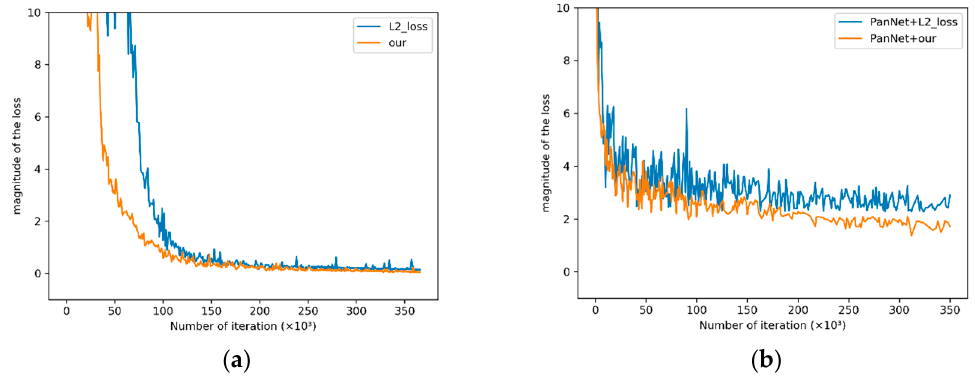
Figure 12. Convergence images of different loss functions. ( a ) The convergence of different loss functions corresponding to the network structure proposed in this paper; ( b )The convergence of different loss functions corresponding to P an Net.